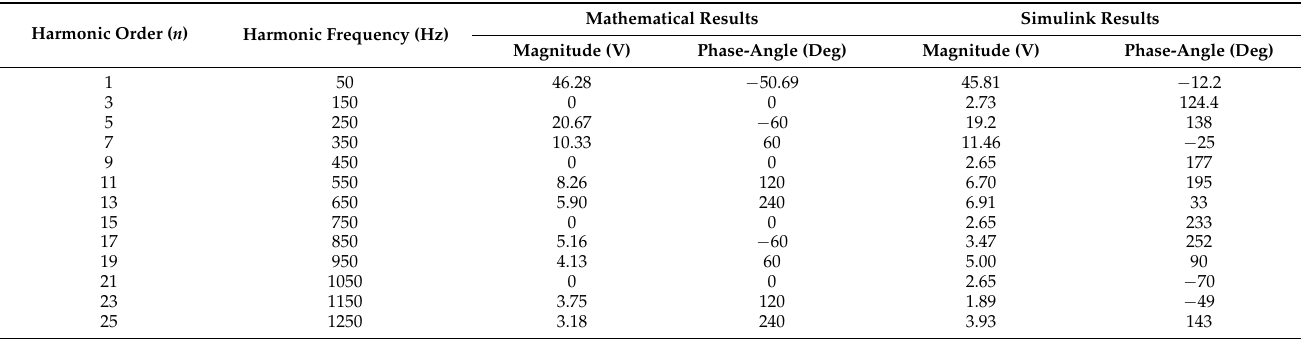
Table 8. Harmonic coefficients of one phase of a three-phase AC voltage controller with a 90 ◦ firing delay with appropriate wave shifting.